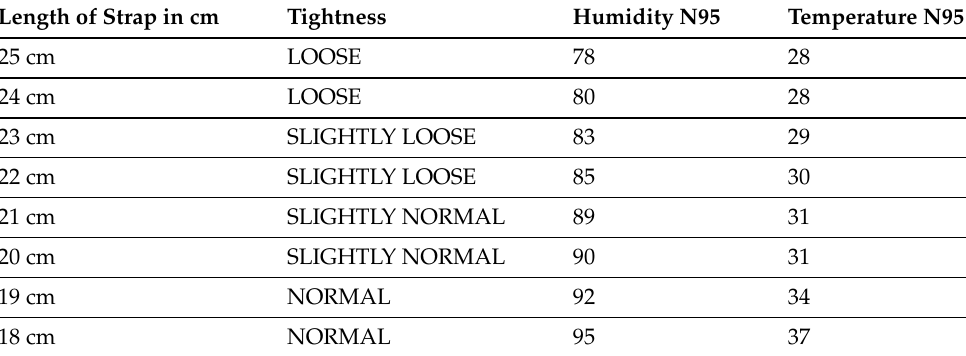
Table 7. Temperature and humidity with varied tightness with a KN95 mask.